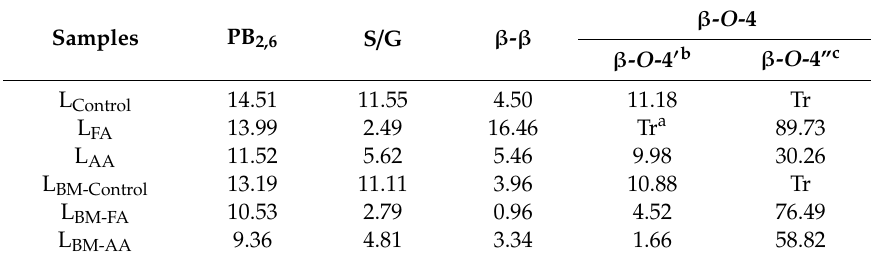
Table 2. Quantitative information on the structures of lignin from the 2D-HSQC